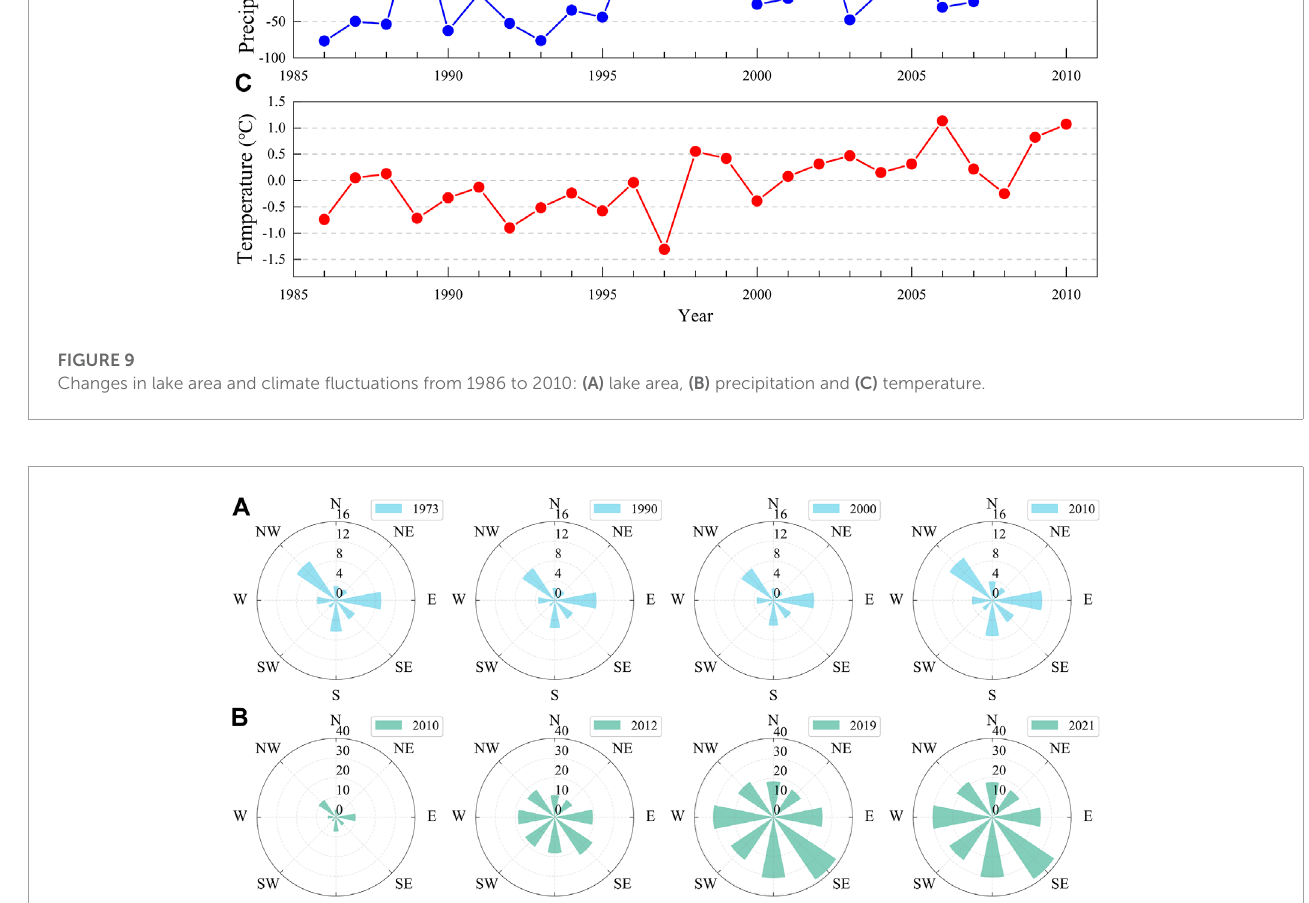
level corresponding to the inundation area was calculated as the